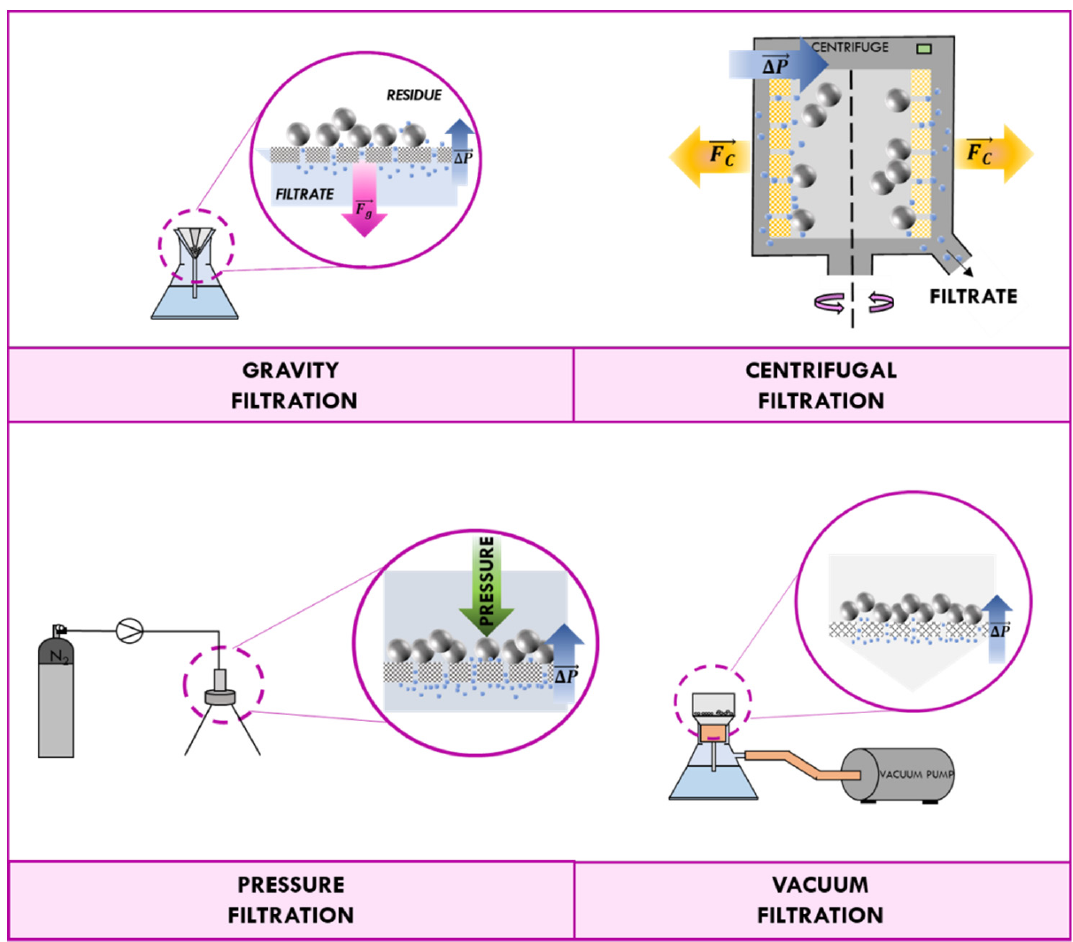
Figure 2. Schematization of filtration processes: gravity, centrifugal, pressure, and vacuum.